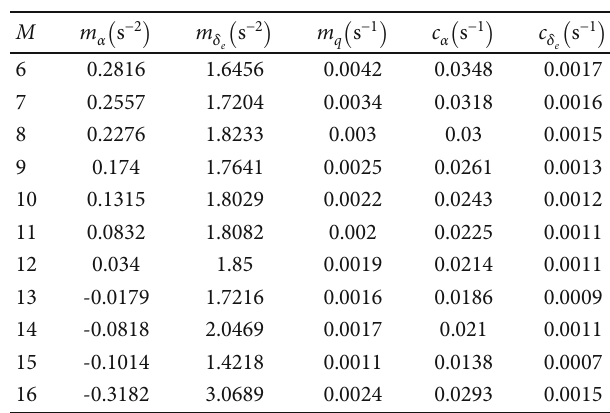
Figure 17: Normal acceleration with self-oscillation strategy. Table 1: Aerodynamic coe ffi cients of the hypersonic